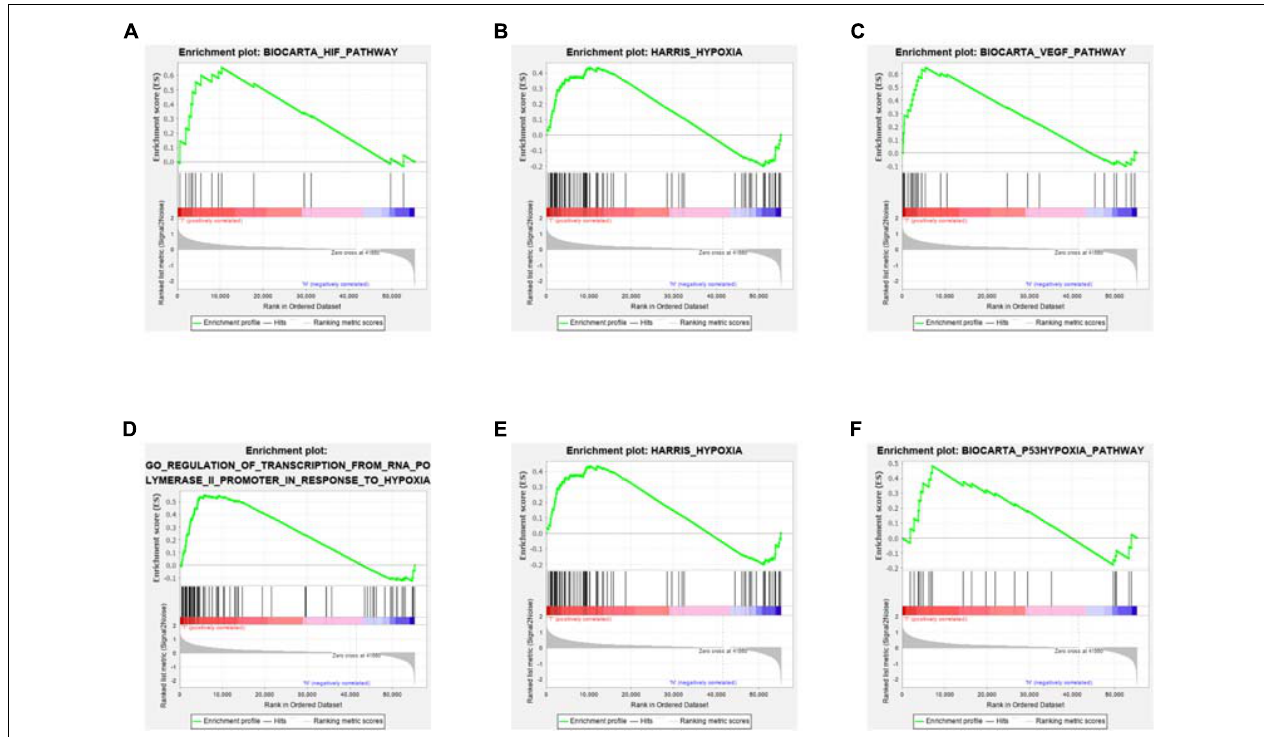
FIGURE 1 | GSEA enrichment results. Compared with the normal samples, most hypoxia-related enrichment terms are significantly upregulated in COAD. Among them, for (A–D) figures, P < 0.05; for (E,F) figures, P >